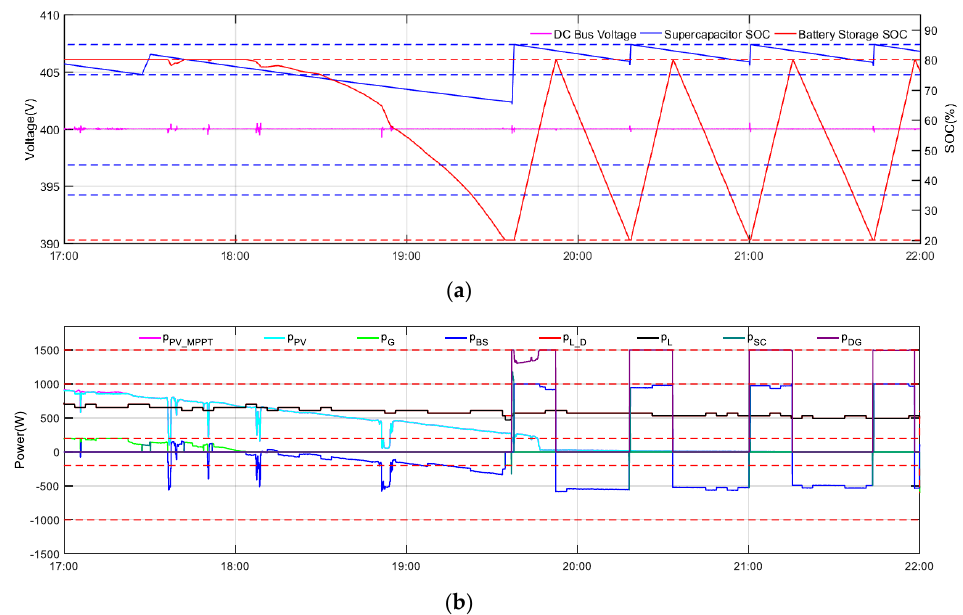
Figure 16. Curves of common DC bus voltage and SOC of storage ( a ) and curves of power ( b ) during the period 17:00 – 22:00.